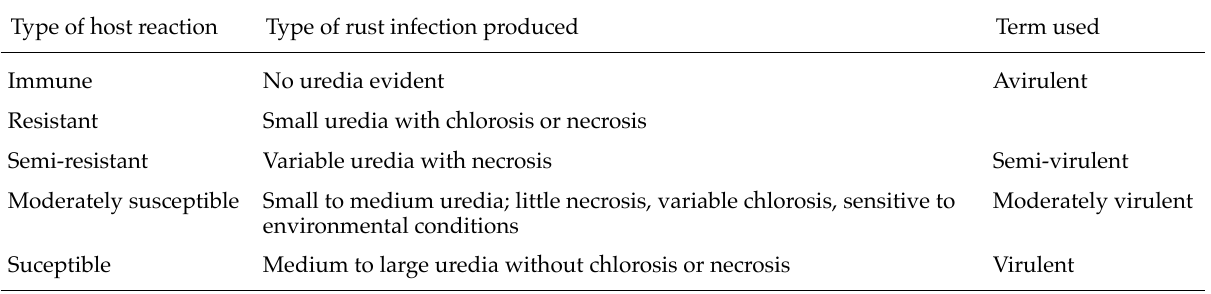
Table 1. Reaction of Linum usitatissimum to inoculation of some Melampsora lini races. Type of host